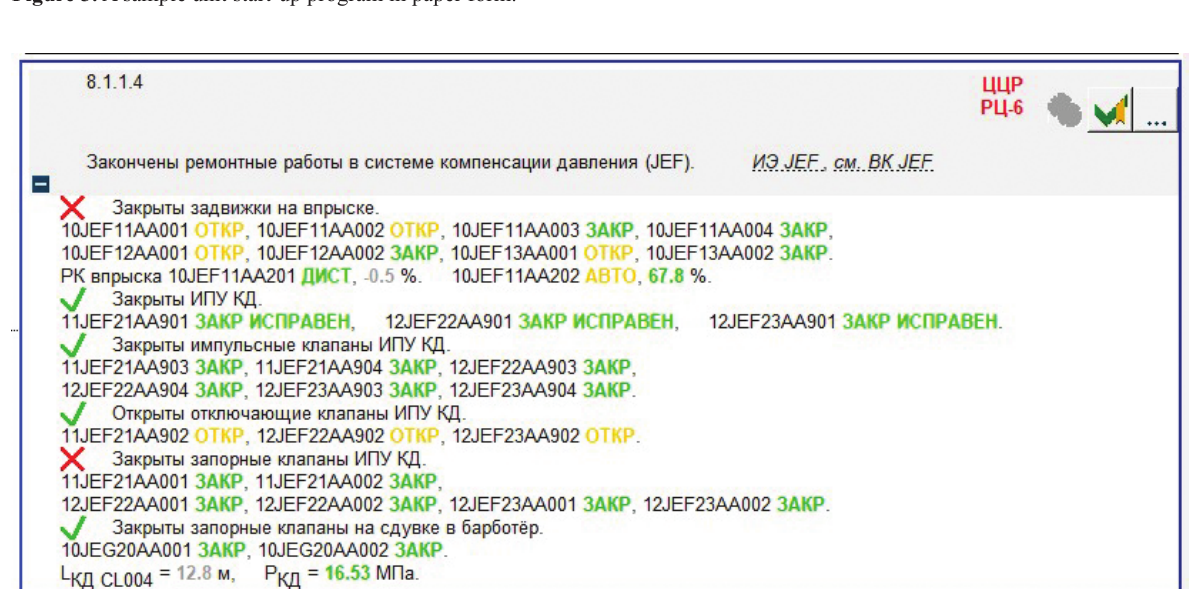
Figure 3. A sample unit start-up program in paper form.